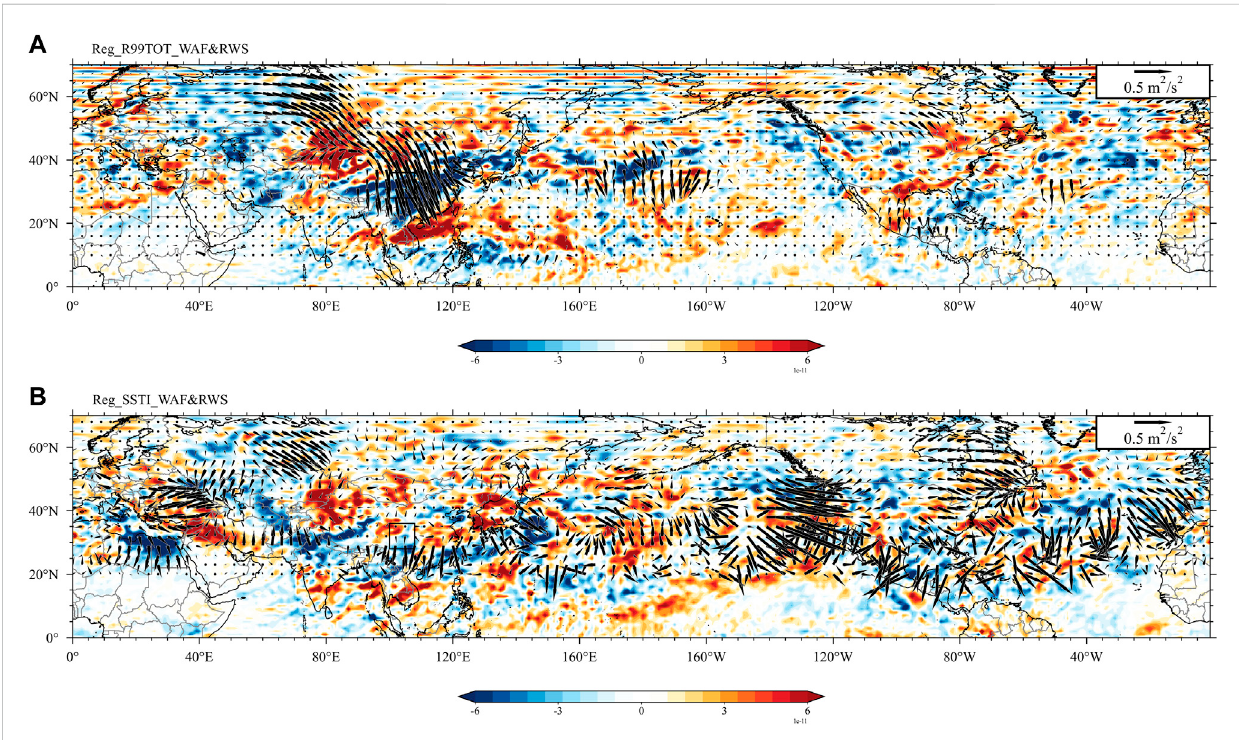
FIGURE 8 WAFs(Vectors;Unit:m 2 · s − 2 )andRWS(Shading;Unit:10 – 10 m 2 · s − 1 )at200 hParegressedontothe (A) interannualcomponentofPC1and (B) SSTIfrom 1961 – 2021,